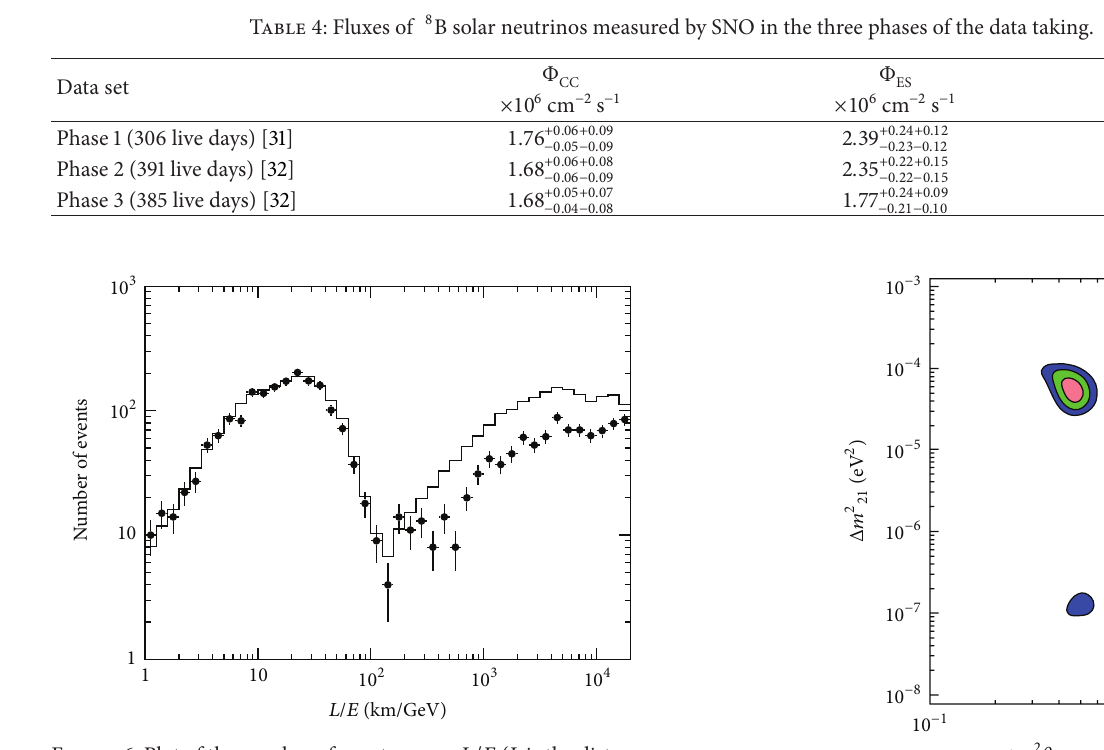
Figure 6: Plot of the number of events versus 𝐿/𝐸 ( 𝐿 is the distance between the neutrino production and the detector and 𝐸 is the neutrino energy) for the Super-Kamiokande data (points with error bars); the histogram is the result of the Monte Carlo simulation for atmospheric neutrino events without oscillations [17].